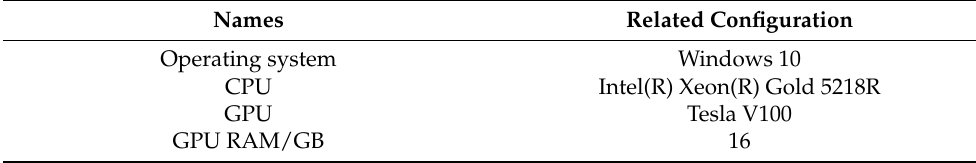
Table 1. Experimental environment